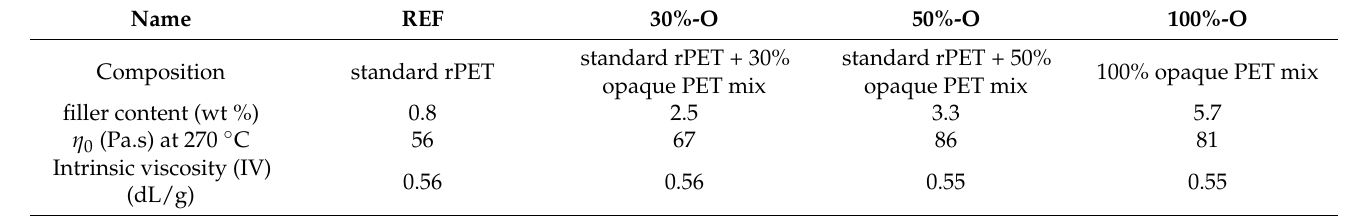
Table 2. Characteristics of the extruded blends between standard and opaque rPET matrices.